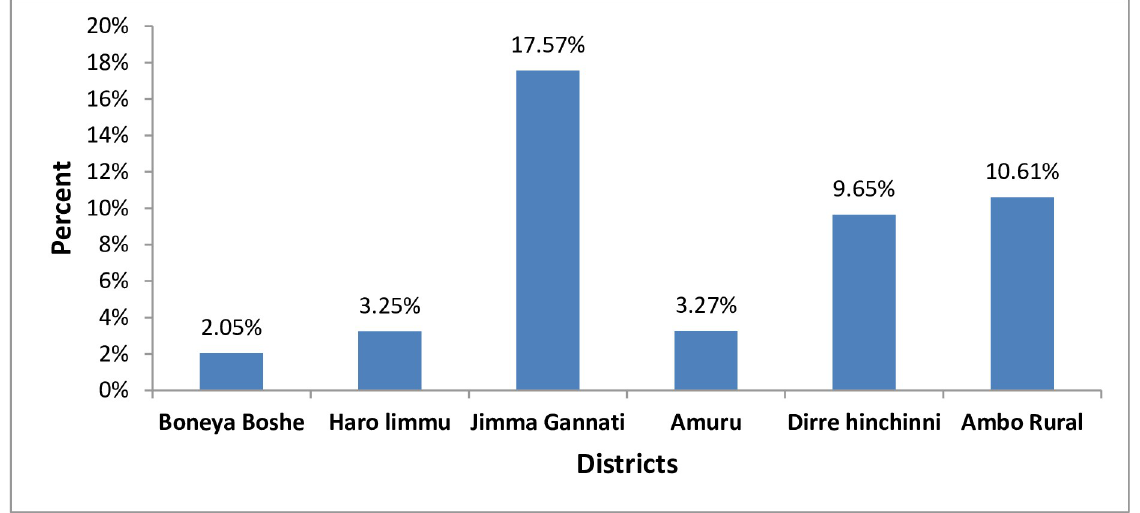
Fig 6. Proportion of respondents who experienced side effects after swallowing MDA drugs, mass drug administration for trachoma coverage survey in six districts of East Wollega, West Shewa and Horroguduru Wollega Zones, Oromia